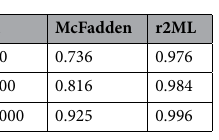
Table 1. Statistics and statistical criteria under different sample